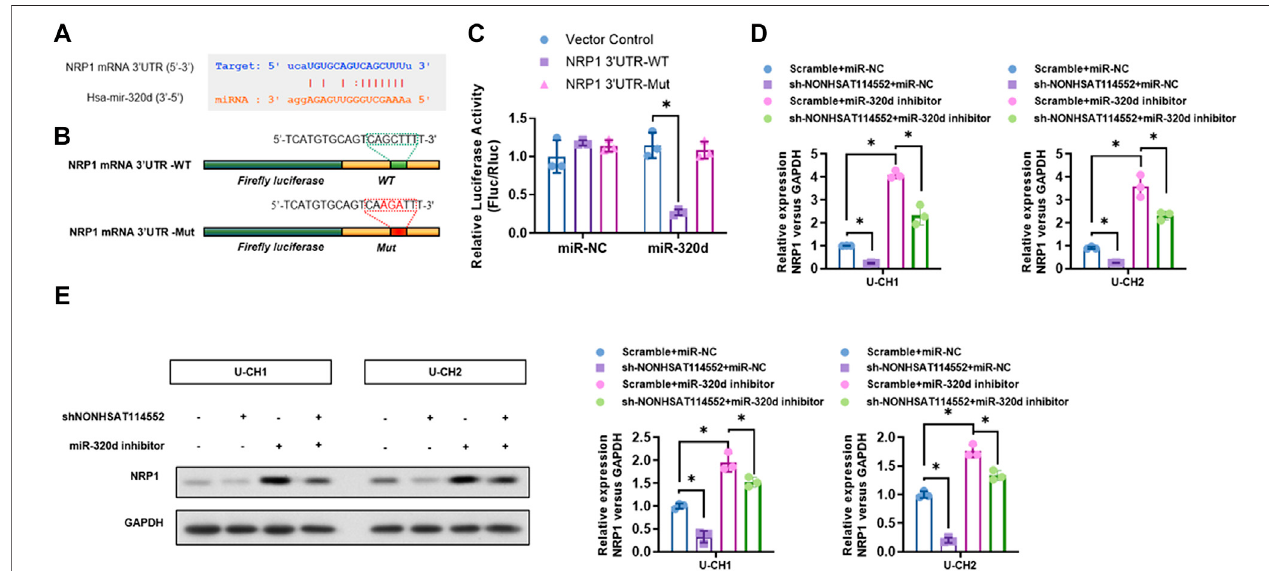
FIGURE5| NRP1isonetargetgeneofmiR-320dandregulatedbyNONHSAT114552andmiR-320d. (A) .BioinformaticanalysispredictedmiR-320dtargetsitein the3 ′ UTRofNRP1 (B) .ThepictureindicatedluciferasereporterplasmidincludingWTorMutNRP1 (C) .Onthebasisofluciferasereporterassay,miR-320dsigni fi cantly decreased luciferase signals of NRP1-WT reporters, but did not affect NRP1-Mut reporters (D) . NRP1 mRNA expression was investigated in groups of sh- NONHSAT114552+miR-320d inhibitor, miR-320d inhibitor, sh-NONHSAT114552 or scramble (E) . NRP1 Protein expression was measured in groups of sh- NONHSAT114552+miR-320d inhibitor, miR-320d inhibitor, sh-NONHSAT114552 or scramble.